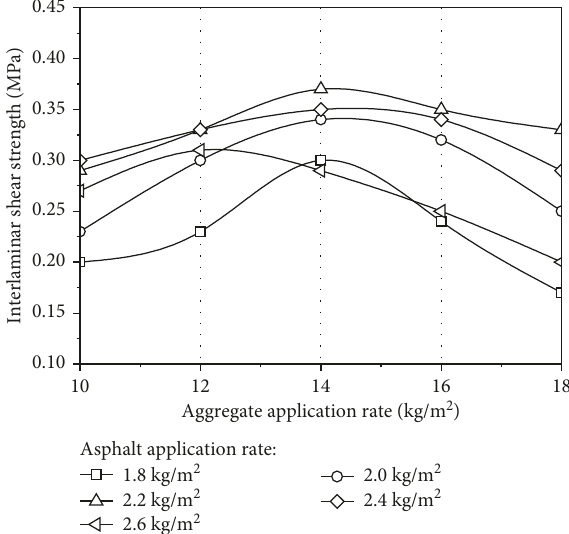
Figure 10: Interlaminar shear test results at 45 ° C.